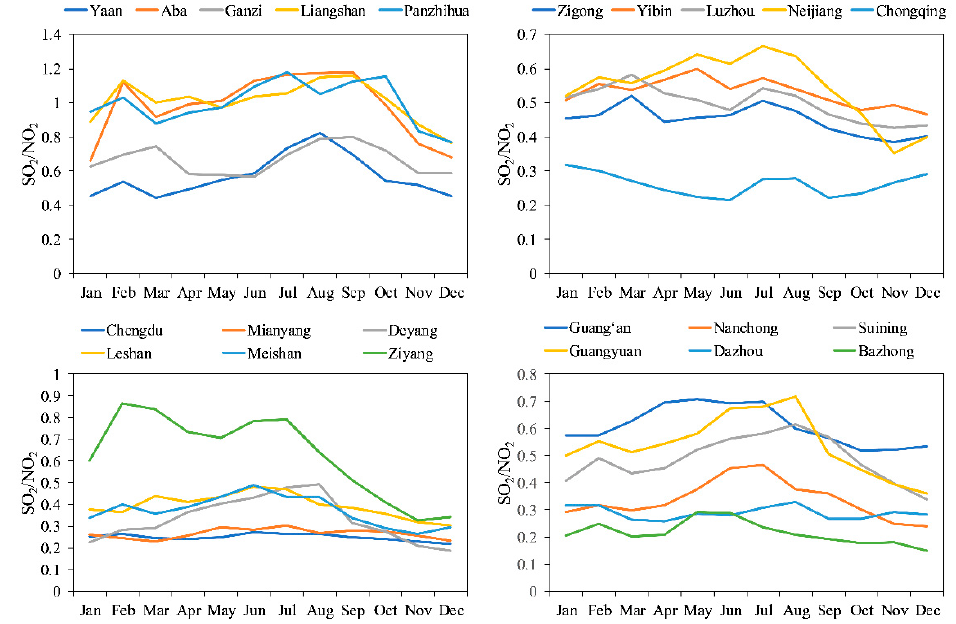
Figure 8. The monthly average SO 2 /NO 2 ratio of each city.